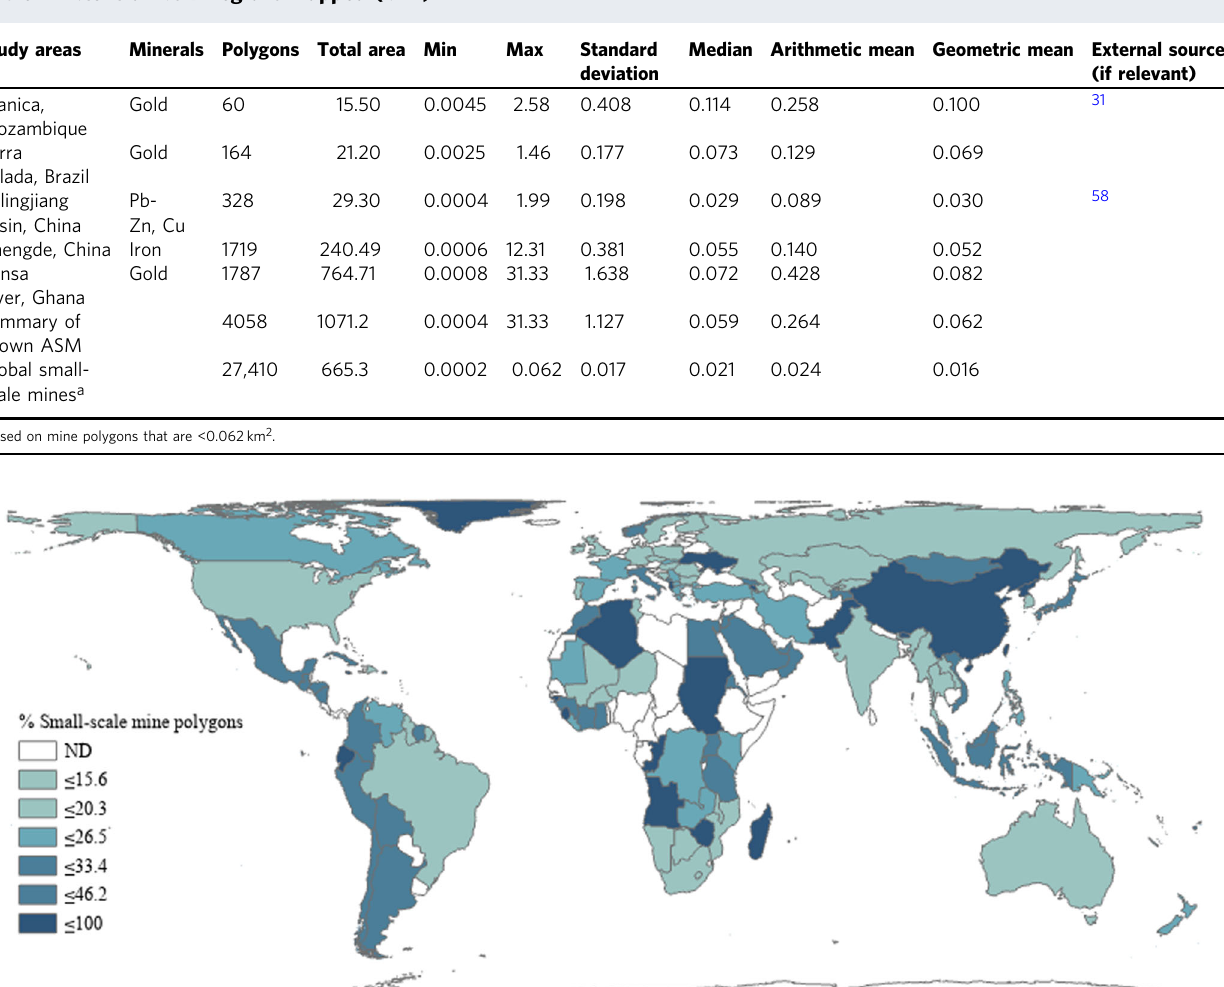
Table 2 Extent of ASM regions mapped (km 2 ).